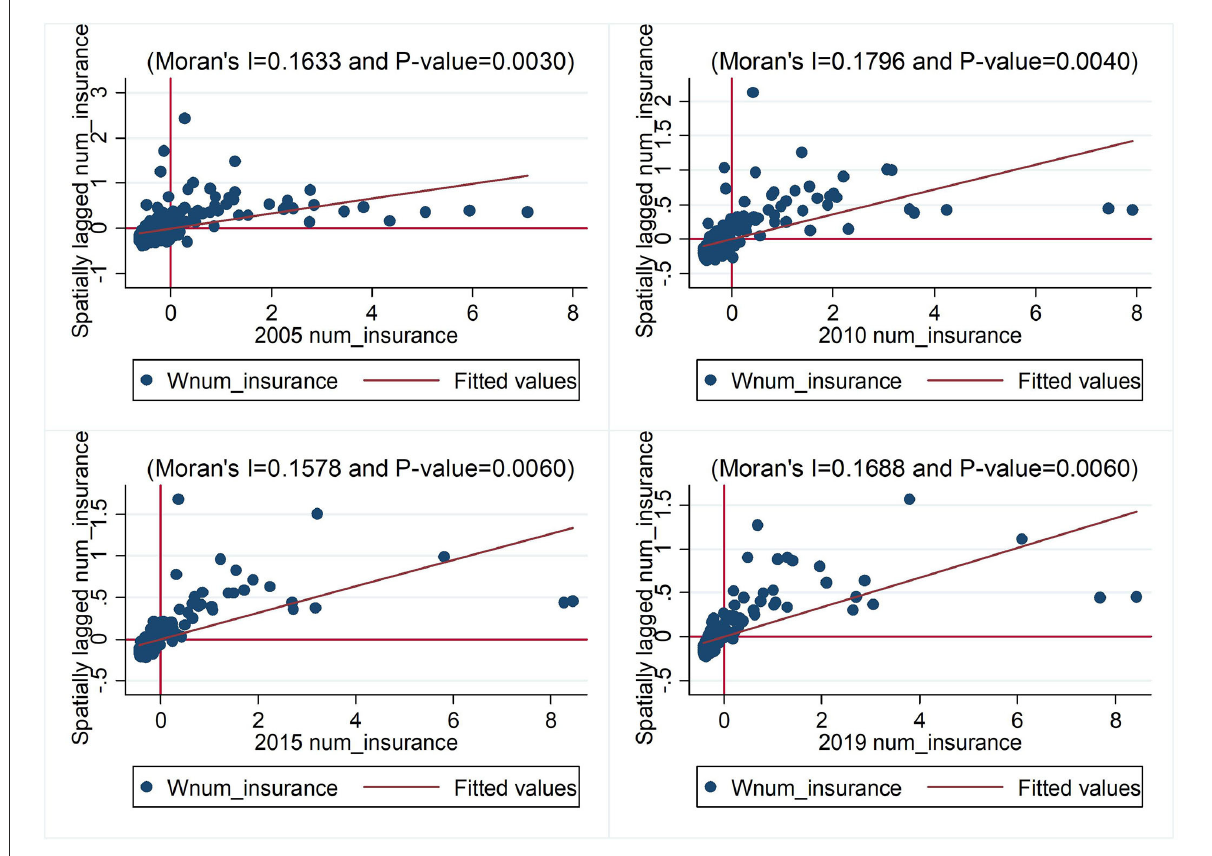
FIGURE2 Univariate local Moran’s I.